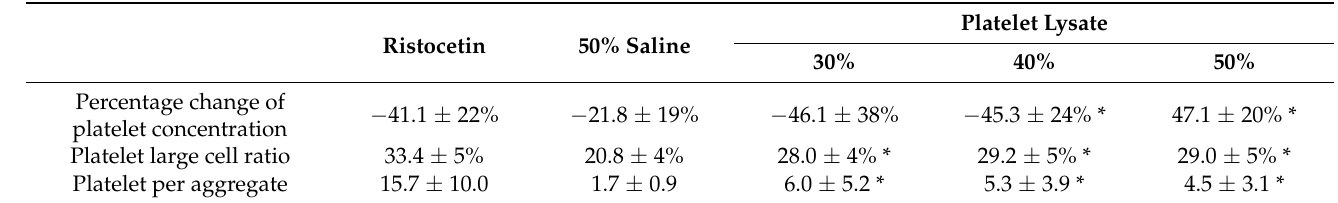
Table 2. Changes in platelet concentration, platelet large cell ratio, and platelet per aggregate in different constituents of platelet lysate and whole blood.